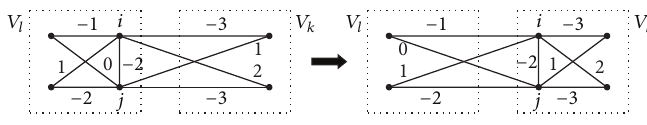
Figure 3: Simultaneously relocating two